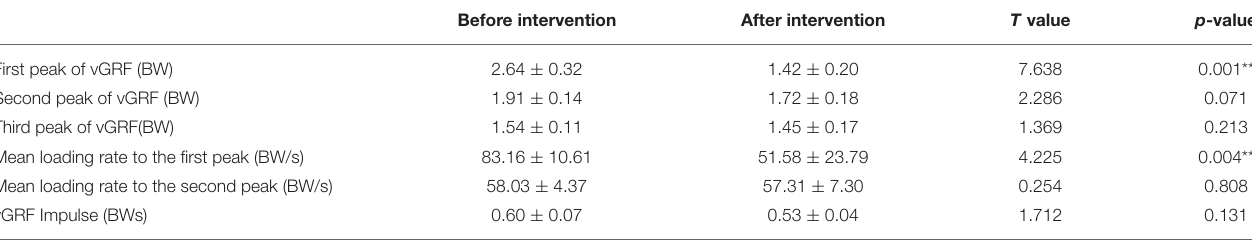
TABLE 1 | The outcomes of vertical reaction force.